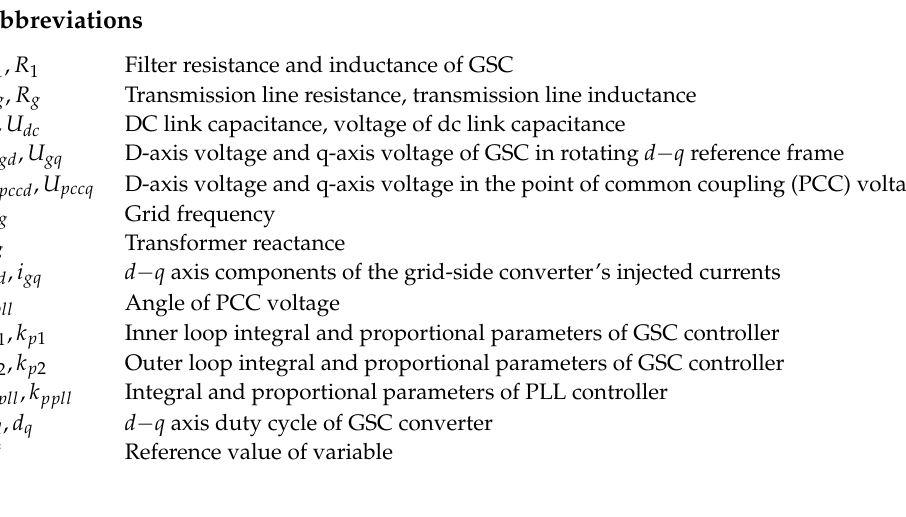
Figure 41. FFT analysis of i gd in PI controller (change k ipll